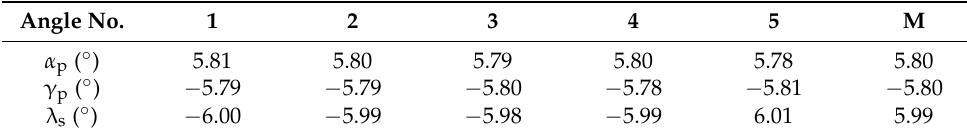
Figure 12. ATOS II Triple Scan: ( a ) view of measuring setup, ( b ) an example showing the measurement of angle α p. Table 1. Results of cutting-edge geometry measurement.